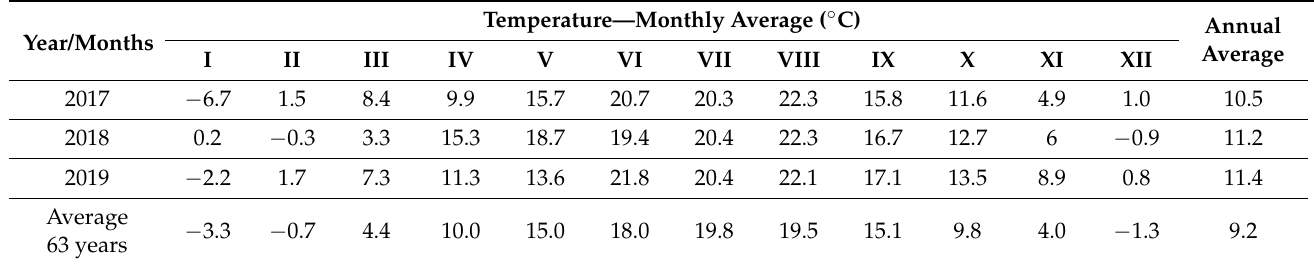
Table 1. Thermal regime from 2017 to 2019 at the Agricultural Research and Development Station Turda (ARDS Turda). Year/Months